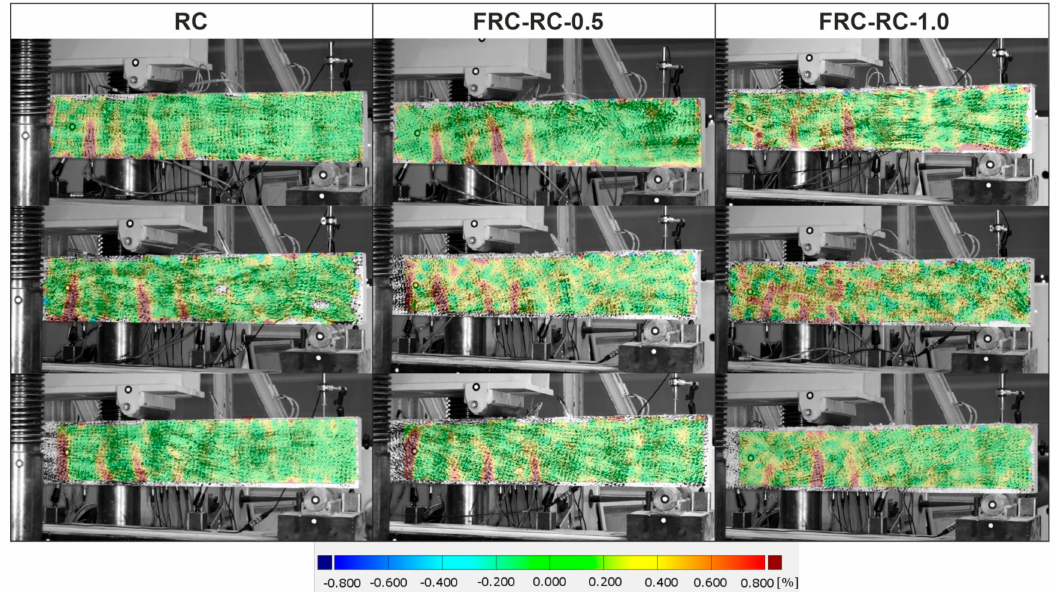
Figure 20. Distribution of the principal strain on the front surface of the RC/FRC–RC beams based on DIC.